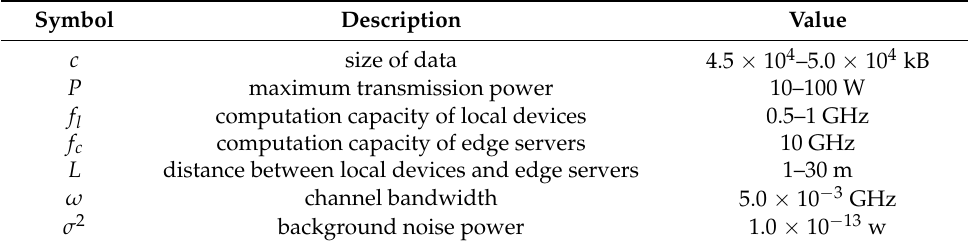
Table 2. Detailed parameters of the multi-user computation offloading